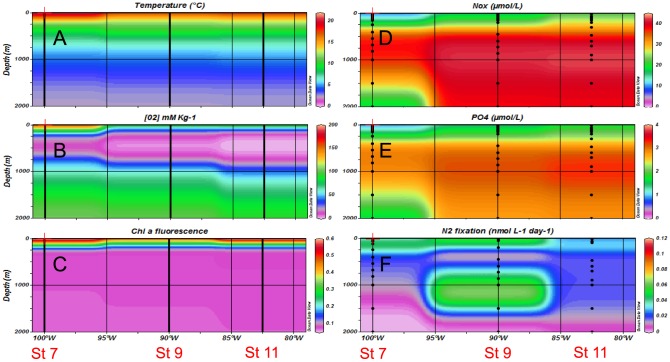
Horizontal and vertical distributions of hydrological and biogeochemical parameters during the 2011 cruise (R/V Melville) – Northern transect (10°S).(A) temperature, (B) dissolved oxygen, (C) chlorophyll a fluorescence, (D) NO3
− concentrations, (E) PO4
3− concentrations, (F) Mean N2 fixation rates (n = 3).